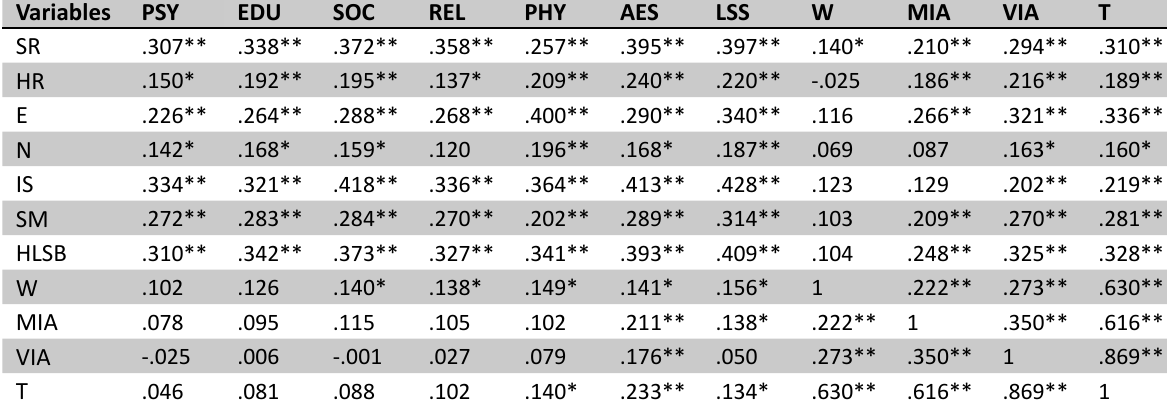
Table 5 . The relationship between leisure satisfaction, physical activity levels and healthy life-style behaviors of sport science students